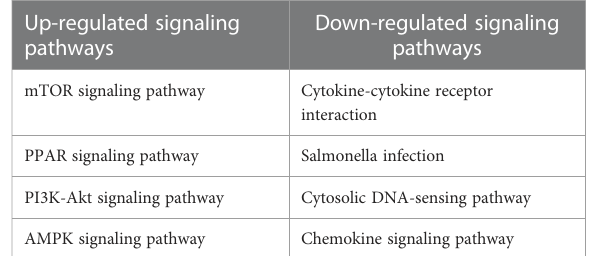
TABLE 7 List of KEGG pathways up-regulated and down-regulated between the experimental group at 48 h and 24 h.